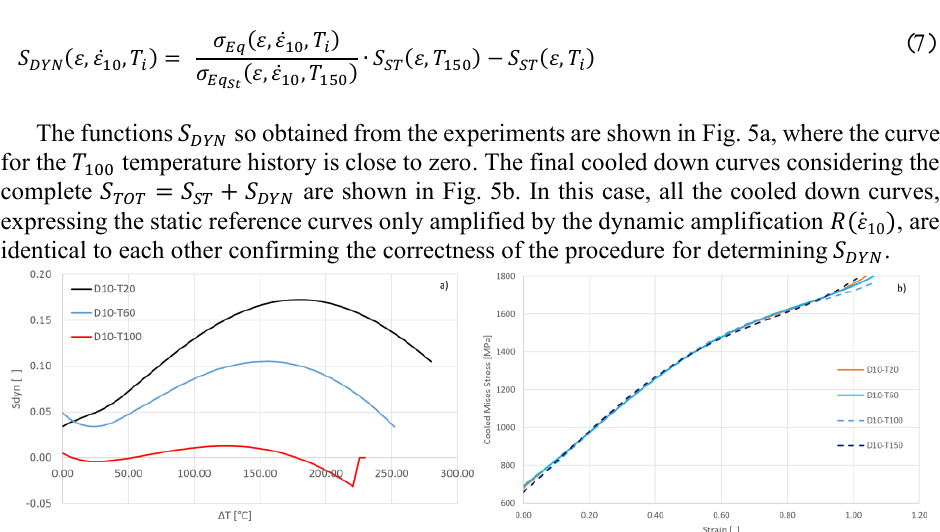
Fig. 5. Dynamic tests at the same strain rate (10 s -1 ) and different initial temperatures: (a) Dynamic softening; (b) Equivalent curves cooled down considering the total softening 𝑆 𝑇𝑂𝑇